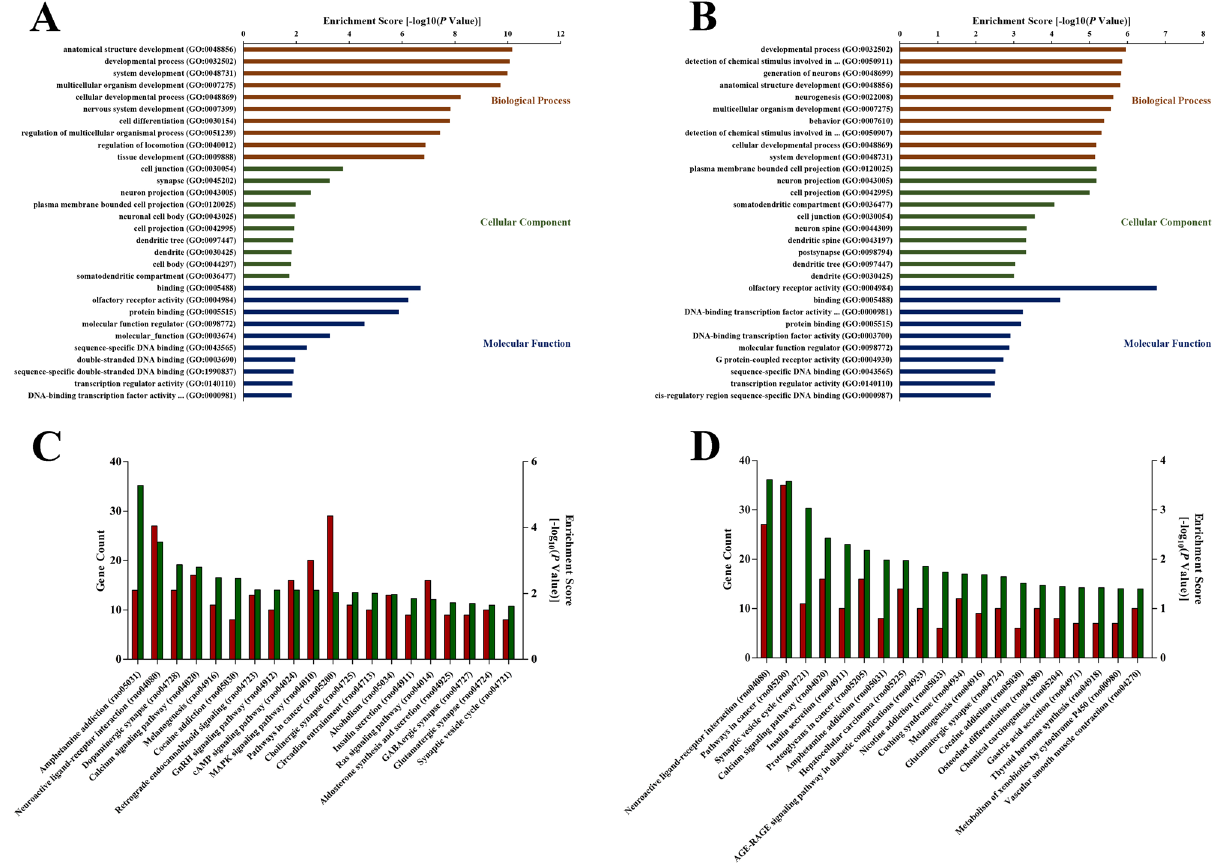
Figure 6. The GO and KEGG pathway annotations of differentially expressed mRNAs in ICH. ( A ) The top 10 most significant enrichment terms in biological process, cellular component, and molecular function, respectively, of differentially expressed mRNAs on day 7 in GO analysis. ( B ) The top 10 most significant enrichment terms in biological process, cellular component, and molecular function, respectively, of differentially expressed mRNAs on day 28 in GO analysis. Red bar represented the term of biological process; green bar represented the term of cellular component; blue bar represented the term of molecular function. The enrichment score (-log 10 scale of corrected P value) expressed the regulational extent of the predicted functions by the differentially expressed mRNAs in ICH rats compared with Sham. ( C ) The top 20 most significant enrichment terms of differentially expressed mRNAs on day 7 in KEGG analysis. ( D ) The top 20 most significant enrichment terms of differentially expressed mRNAs on day 28 in KEGG analysis. Red bar represented the gene count enriched; green bar represented the enrichment score (-log 10 scale of corrected P